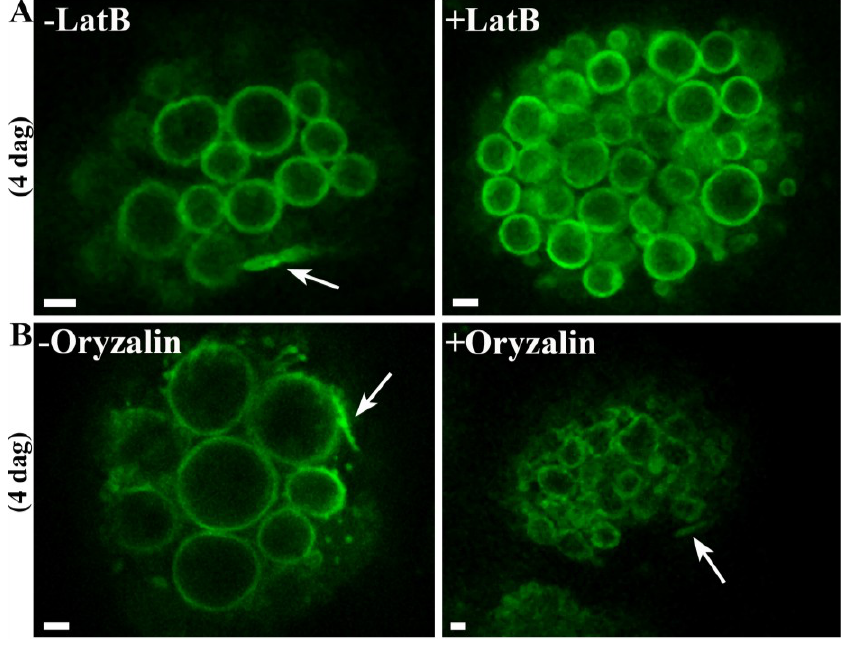
Figure 4. The remodeling of tubular PSV extensions depends on microfilaments but not microtubules. ( A ) Representative pictures from movies showing PSV tubules in untreated cells (arrow) but no PSV tubules in cells treated with latrunculin B; ( B ) Representative pictures showing PSV tubules in untreated cells (arrow) and in cells treated with oryzalin. Scale bar = 2